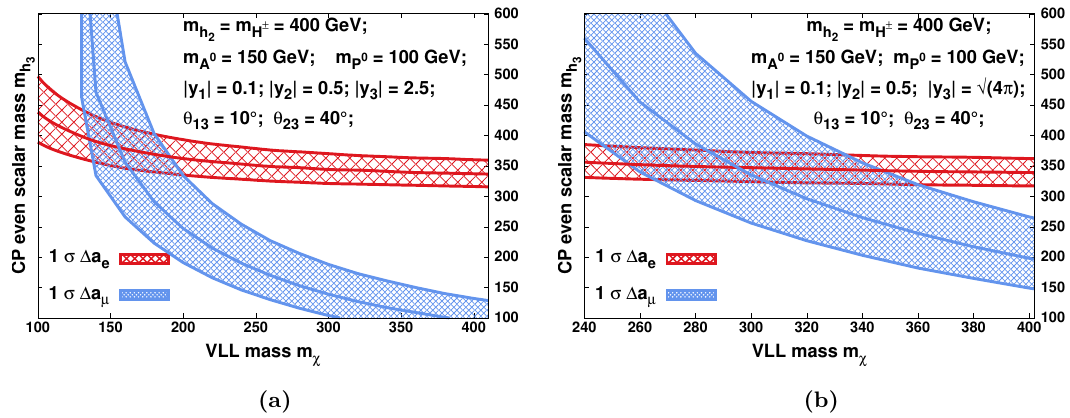
Figure 8. Colored solid contours and associated one sigma bands are shown in m h 3 − m χ satis- fying ∆ a µ = (251 ± 59) × 10 − 11 [3] (in blue) and ∆ a e = [ − 88 ± 28 (expt . ) ± 23 ( α ) ± 2 (theory)] × 10 − 14 [11] (in red). Contours are drawn for Yukawa couplings | y 3 | = 2.5 and the perturbative limit √ 4 π in figures 8a and 8b respectively, while other physical masses, couplings and angles remain same for the both. The overlap of the two bands depict the common parameter space.